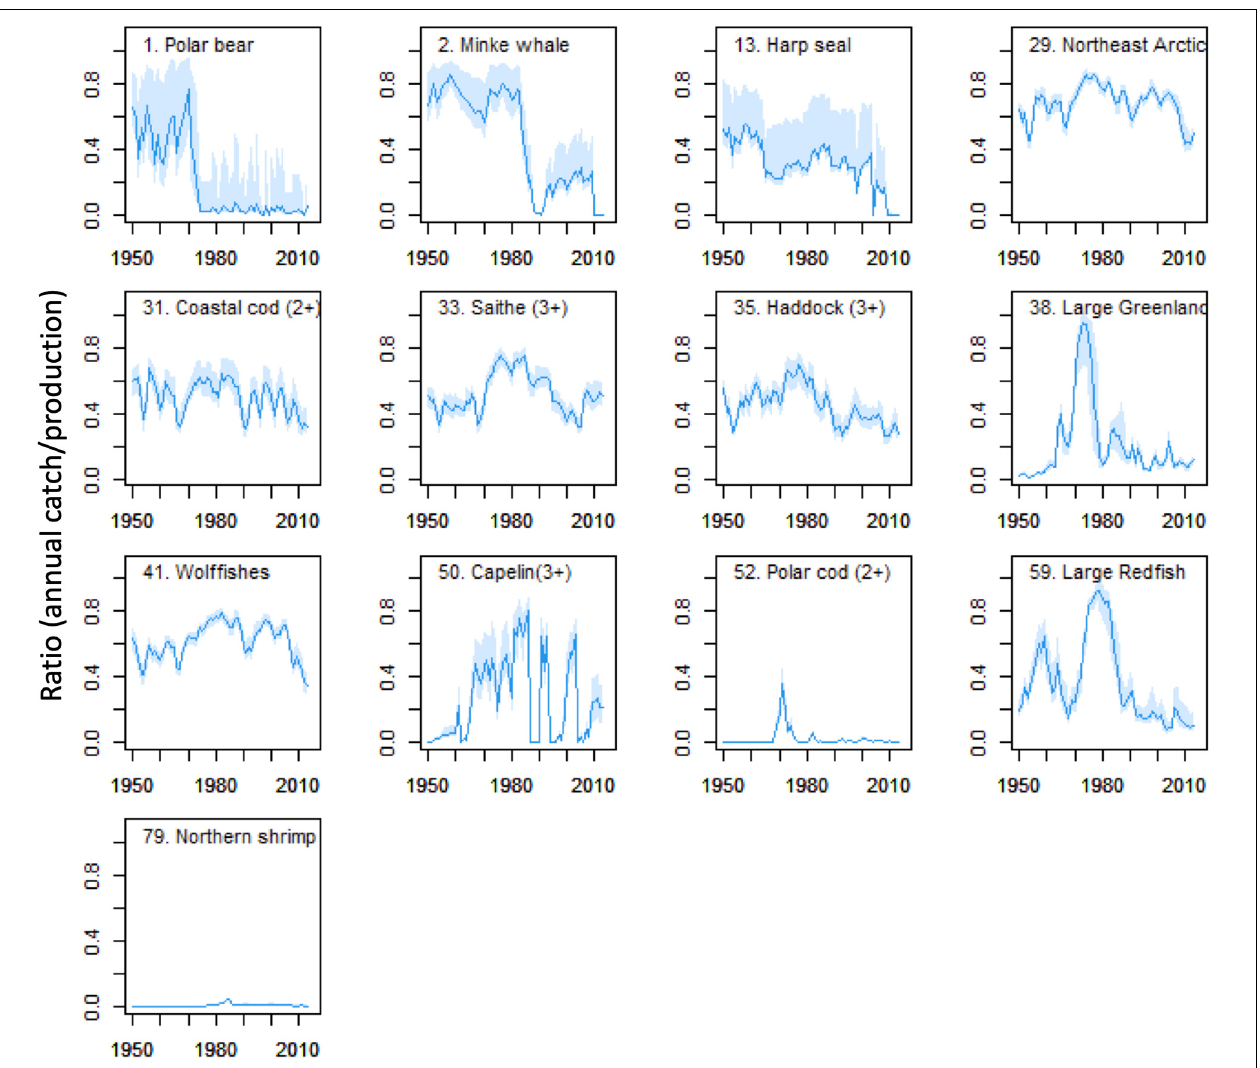
FIGURE 7 | Changes in ratio of catch to production (Y/P) of exploited Ecopath groups during the period 1950–2013. Based on data from M10 Ecosim model. Blue line shows mean value and blue bands shows 2.5 and 97.5 percentiles from Monte Carlo replicates.